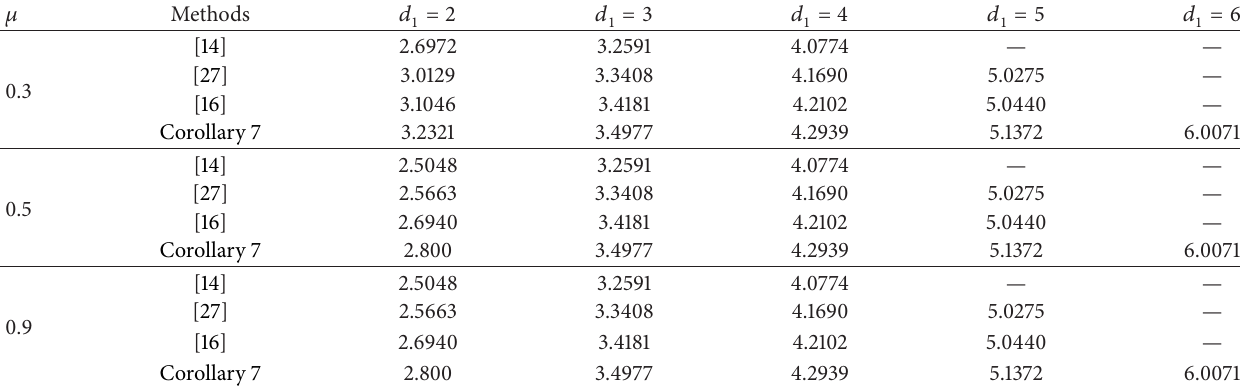
Table 3: Admissible upper bounds 𝑑 2 with varying 𝜇 and 𝑑 1 .